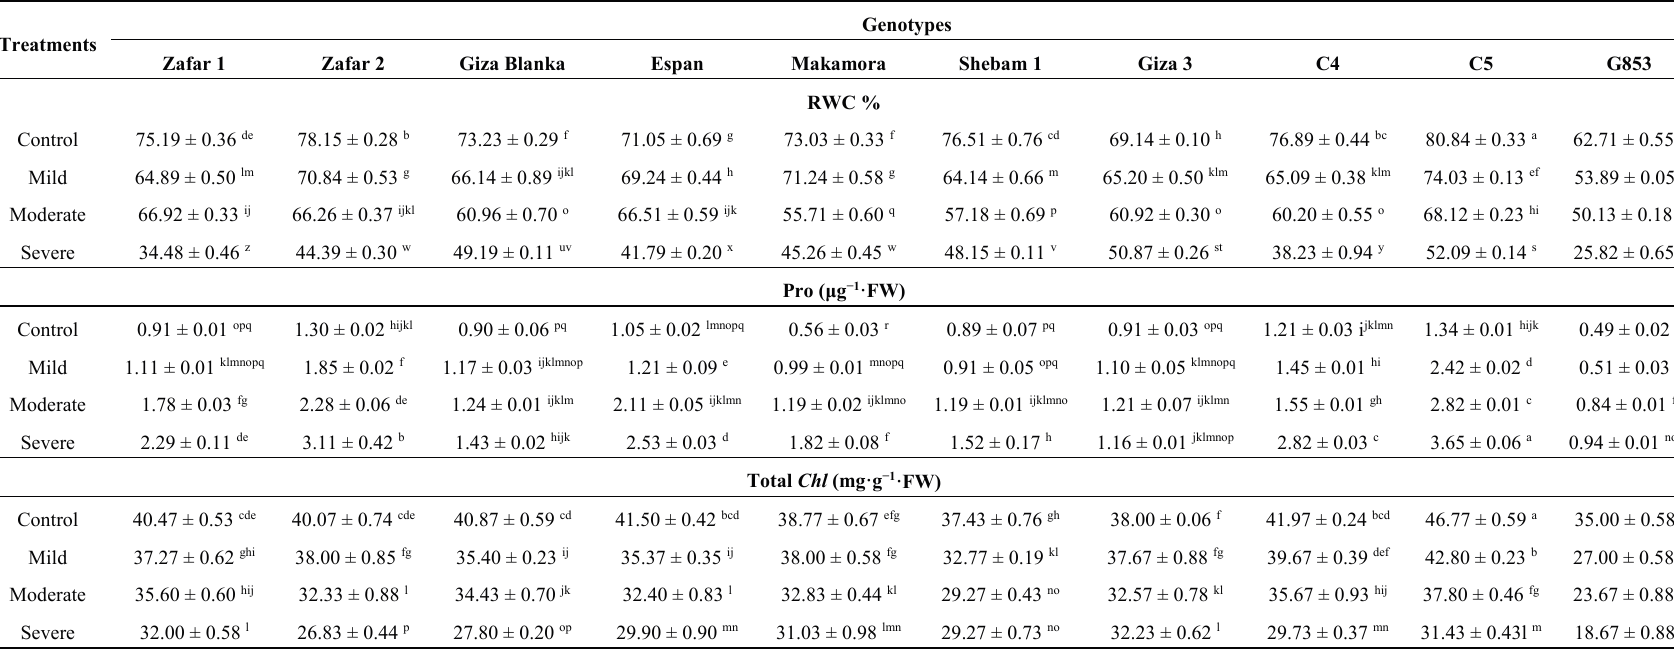
Table 2. Effect of drought stress on leaf relative water content (RWC), proline (Pro) content and total chlorophyll (Total Chlo ) content in faba bean